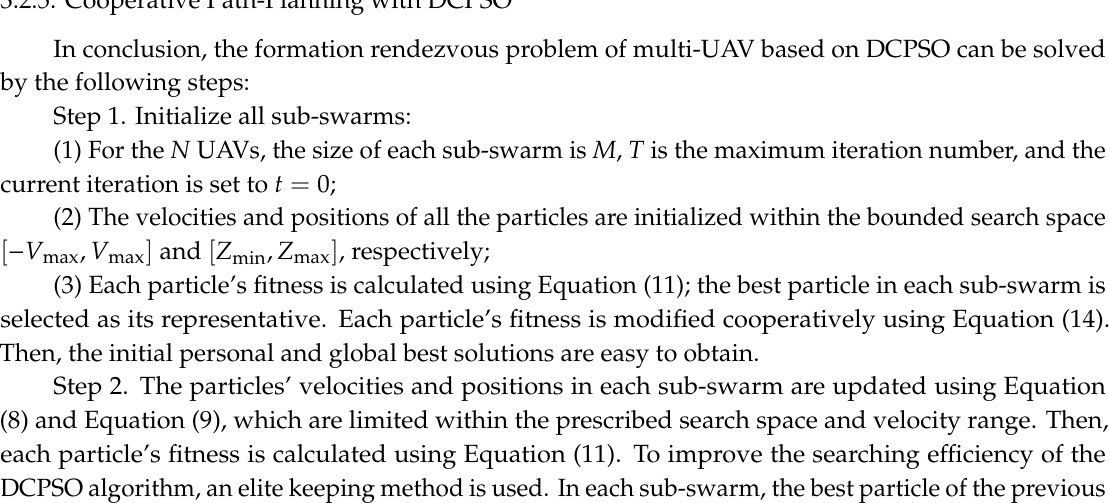
Figure 3. Collision checking for two Pythagorean hodograph (PH) paths.